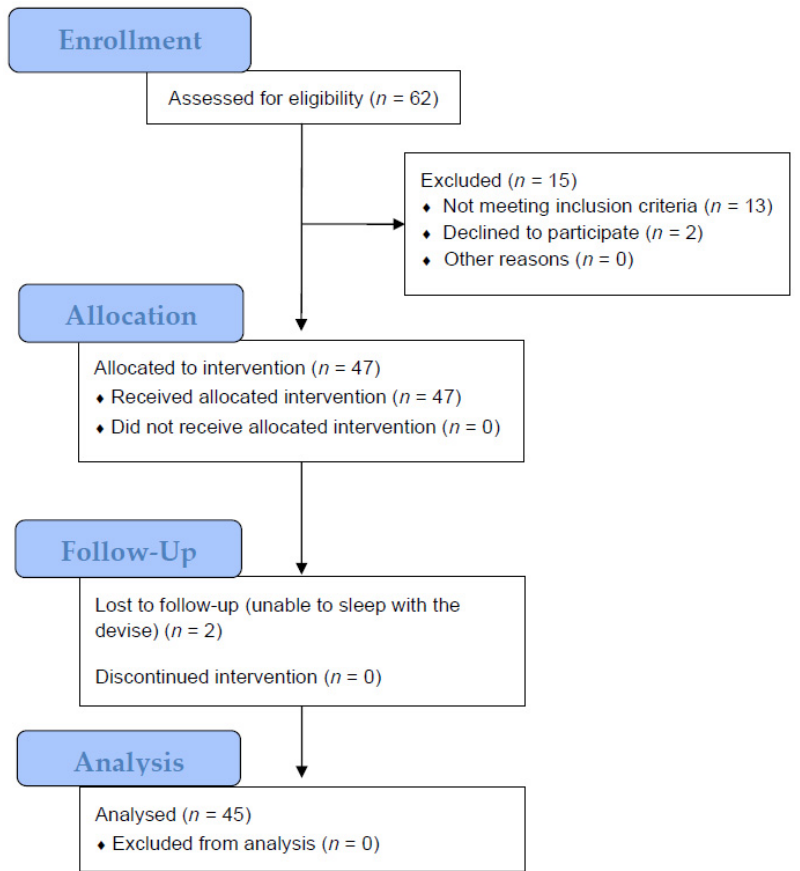
Figure 3. Study process adapted from CONSORT 2010 flow diagram.